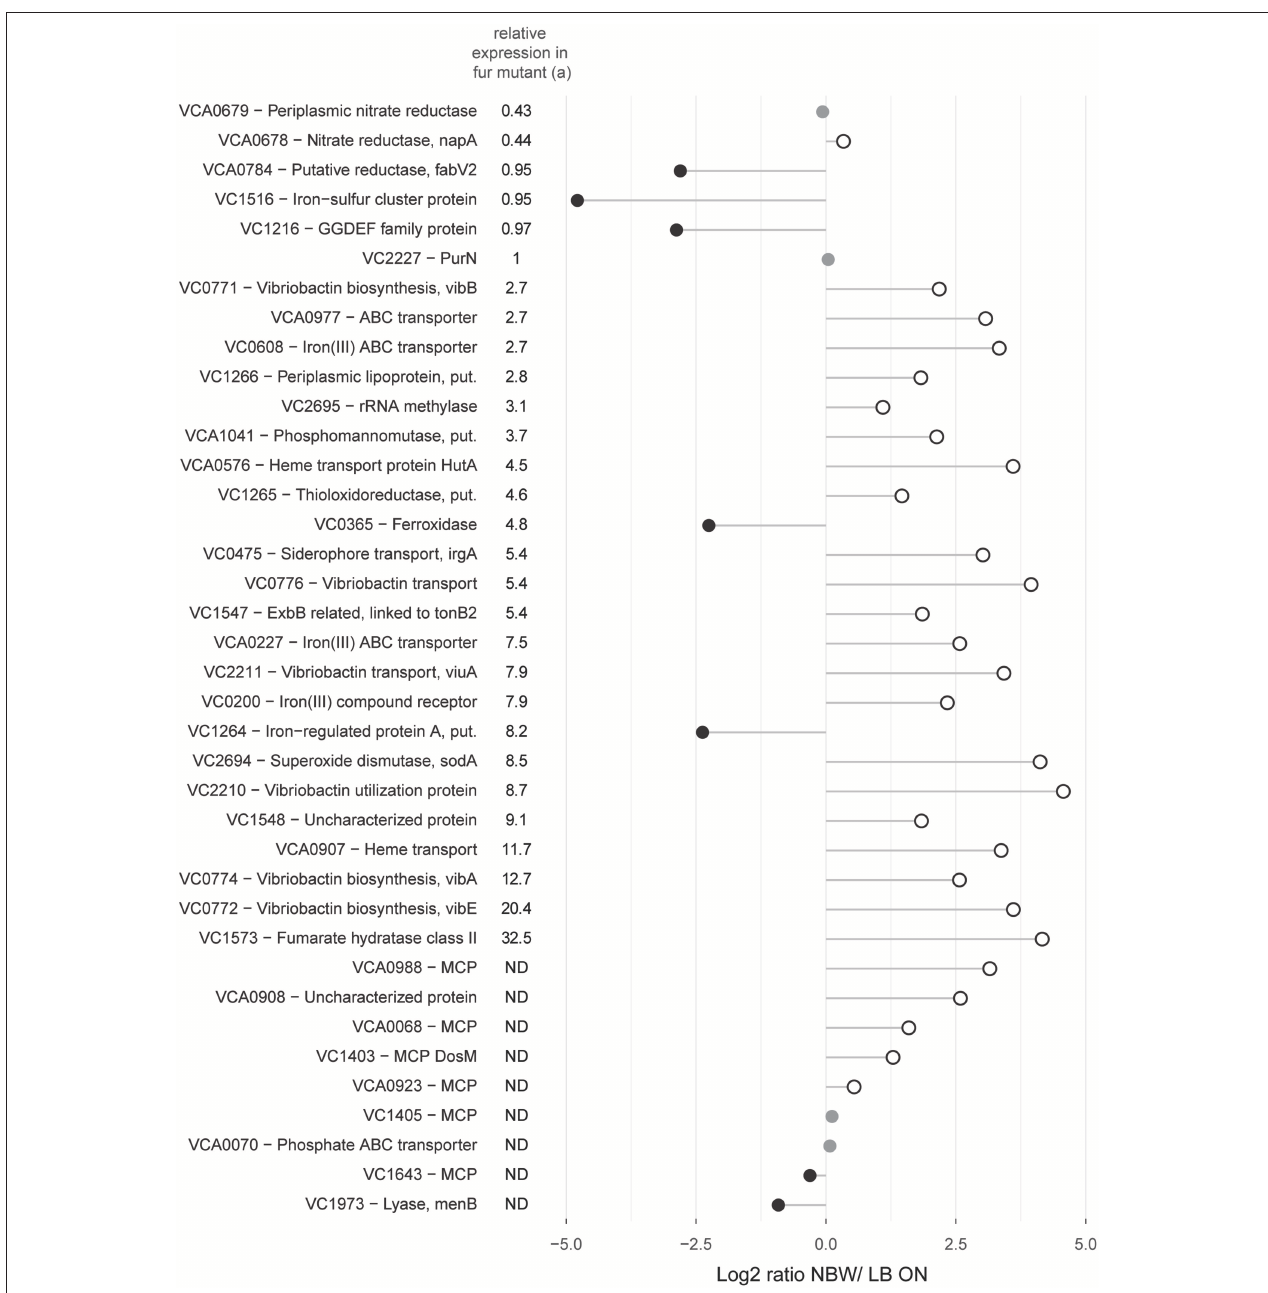
FIGURE 5 | Relative abundances of proteins with predicted Fur binding boxes in their upstream region and/ or shown regulation by iron availability and/ or the master regulator Fur. Depicted is the log 2 -ratio of NBW VBNC cells and LB ON cells. Proteins found in significantly higher abundance in VBNC cells compared to LB ON are indicated by open white circles while significantly lower ratios are shown as black circles. Protein abundances that were not significantly different are colored gray (q < 0.01). (a) Relative expression data was taken from Mey et al. (Mey et al., 2005). The genes of the first five proteins were positively regulated by iron and independently of Fur while the following 24 components were negatively regulated by Fur and iron. ND, not